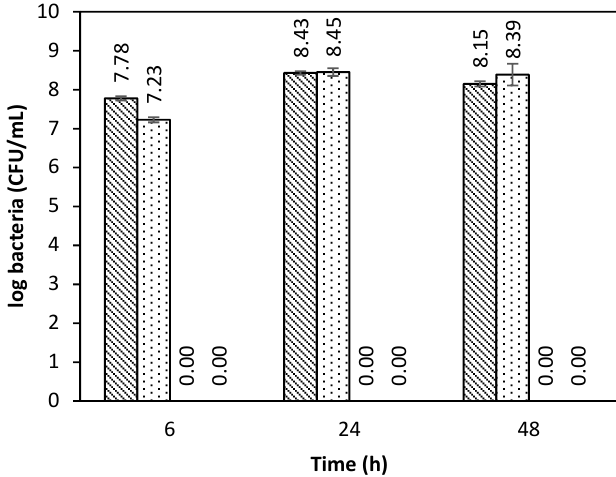
Figure 6. Antimicrobial e ff ect against S. aureus strains of vancomycin-loaded chitosan aerogels and dissolved vancomycin HCl (positive control) compared with the negative controls: Free bacterial culture (diagonal bars) and unloaded chitosan aerogels (dotted). Vancomycin in the aerogels and the positive control provided a fast antimicrobial e ff ect, with complete bacterial inhibition after 6 h of incubation.